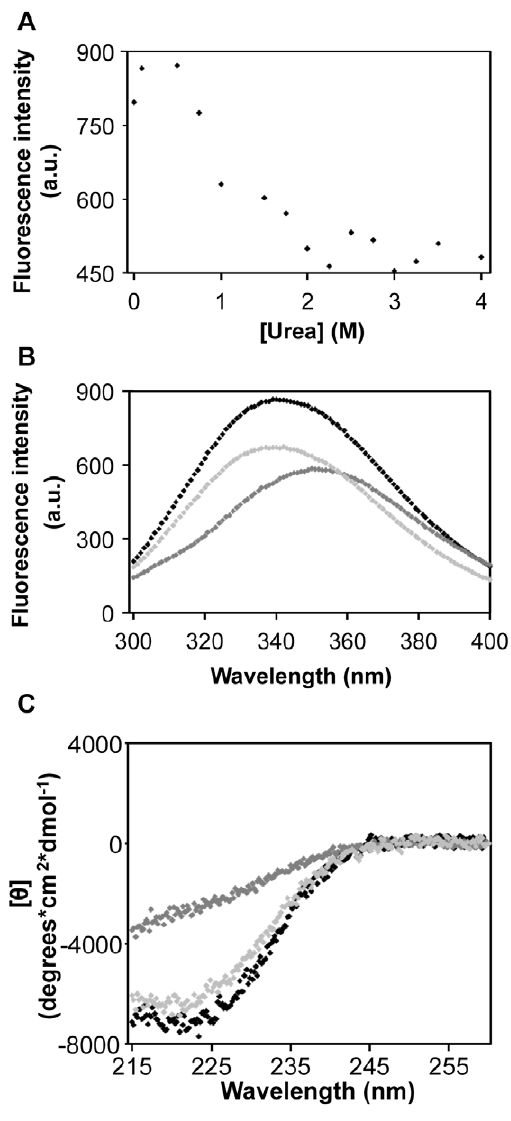
Figure 5. Denaturant-dependent folding of SERK1-KD. ( A ) Urea induced unfolding of SERK1-KD followed by fluorescence spectroscopy. Fluorescence intensity of 0.24 m M of SERK1-KD is measured at 340 nm, upon excitation at 280 nm. The native baseline ranges from 0 to about 0.5 M urea. Above 2 M urea, the unfolded baseline commences. The transition region of urea-induced protein unfolding ranges from about 0.5 to 2.0 M. ( B ) Fluorescence emission of native, unfolded and of refolded SERK1-KD. Black: native SERK1-KD in 0.09 M urea. Dark grey: unfolded SERK1-KD in 6 M urea. Light grey: refolded SERK1-KD, obtained by unfolding the protein for a period of 6 hours in 4.5 M urea, and subsequent dilution of denaturant to 0.09 M urea. Refolding took place during a period of 30 min at room temperature. Refolded SER1-KD has a fluorescence maximum at 340 nm, indicative of folded protein. Approximately 80% of unfolded SERK1-KD properly refolds, according to the difference in fluorescence intensity between native and refolded protein. ( C ) Far-UV CD spectra of native, unfolded and of refolded SERK1-KD. Black: native SERK1-KD in 0.45 M urea. Dark grey: unfolded SERK1-KD in 4.5 M urea. Light grey: refolded SERK1-KD, obtained by unfolding the protein for a period of 6 hours in 4.5 M urea, and subsequent dilution of denaturant to 0.45 M urea. Refolding took place during a period of 30 min at room temperature.